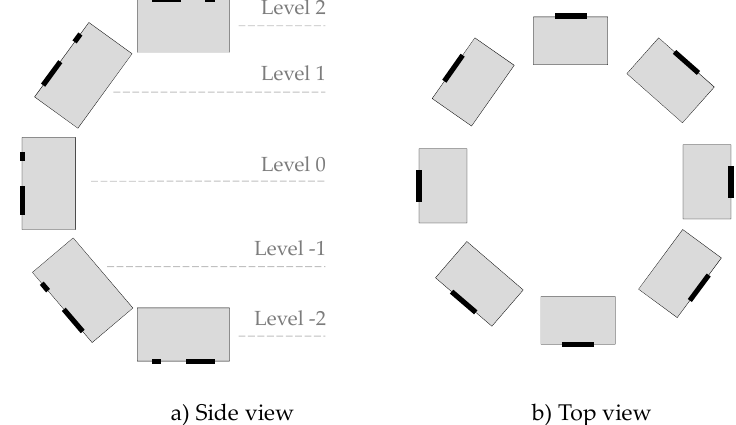
Figure 4. Side ( a ) and top ( b ) view for the measurements with a total sum of twenty six positions.